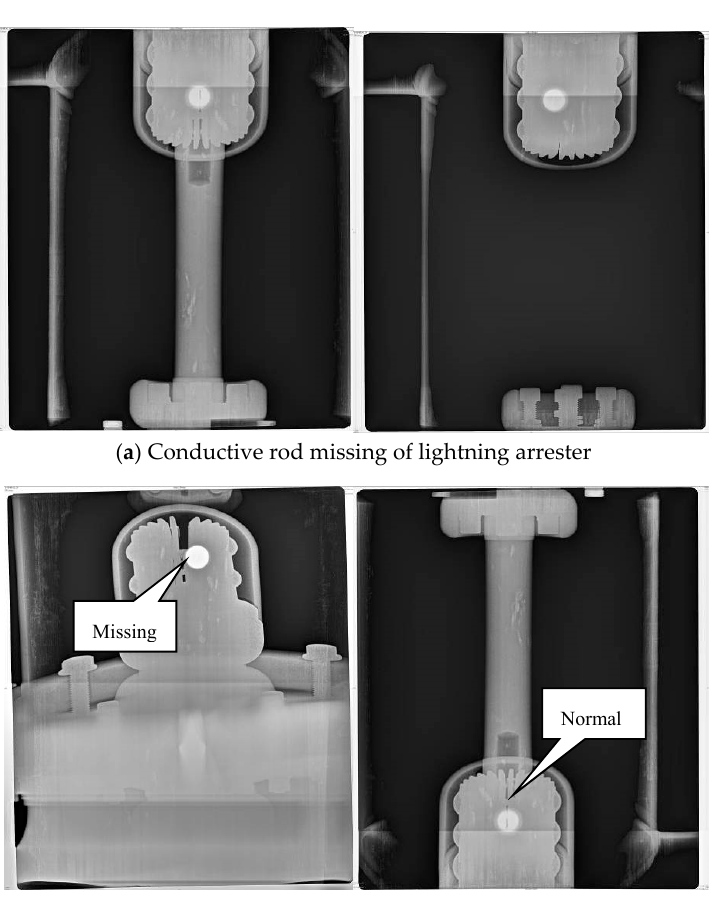
Figure 21. Examples of key components missing.